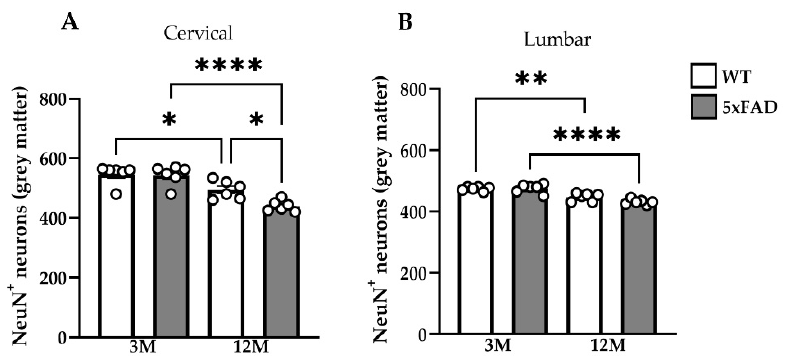
Figure 2. Age-related neuronal loss in the spinal cord of 12M 5xFAD mice. Quantification of the mean number of NeuN + neurons in cervical C2 ( A ) and lumbar L2 ( B ) sections displayed a significant neuronal loss in 12M 5xFAD mice compared with their WT littermates in cervical ( A ) but not in lumbar ( B ) sections as well as compared with 3M 5xFAD mice in cervical and lumbar GM. Statistical analysis was performed by one-way ANOVA followed by Kruskal–Wallis multiple comparisons test ( n = 6 for all genotype and age groups). Data are presented as mean ± SD. Significance is given as: * p < 0.05, ** p < 0.01, **** p < 0.0001.